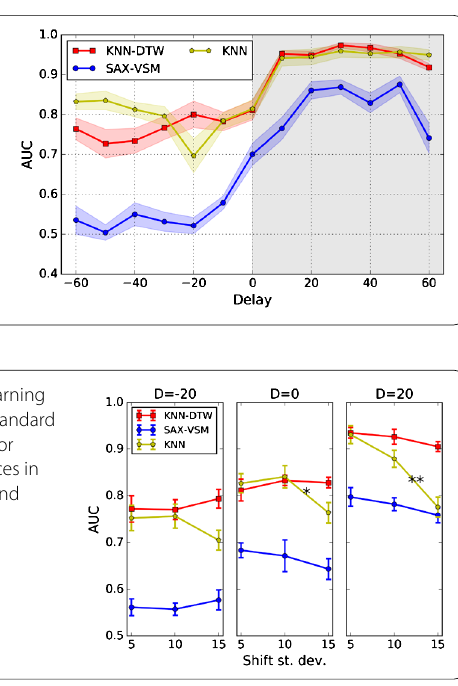
Figure 6 Temporal robustness. AUC of different learning algorithms with random temporal shifts versus the standard deviation of the shifts. We repeated the experiment for various delay values D . Significance levels of differences in consecutive experiments are marked as (*) p < 0.05 and (**) p <